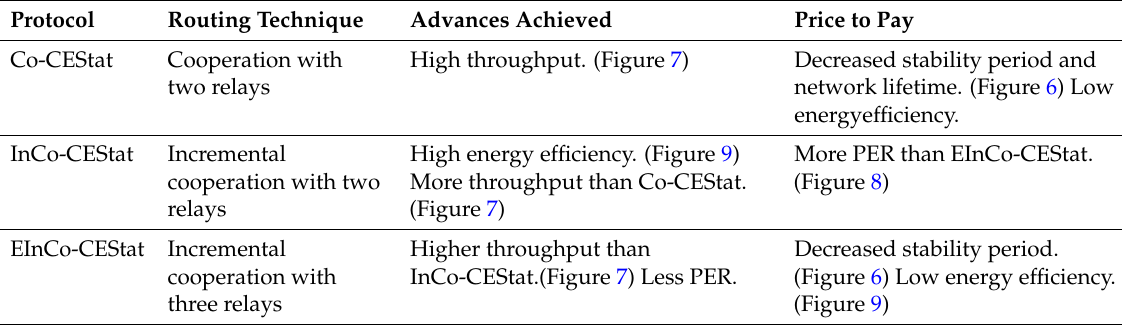
Table 7. Performance trade-offs made by the routing